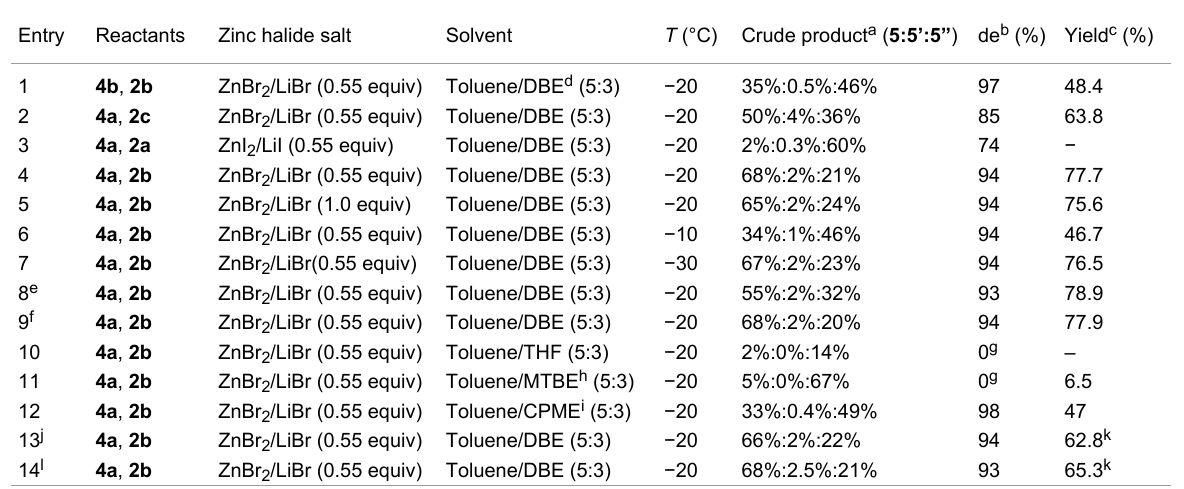
Table 1: Conditions for the stereoselective synthesis of β - C -arylglucoside 5 .